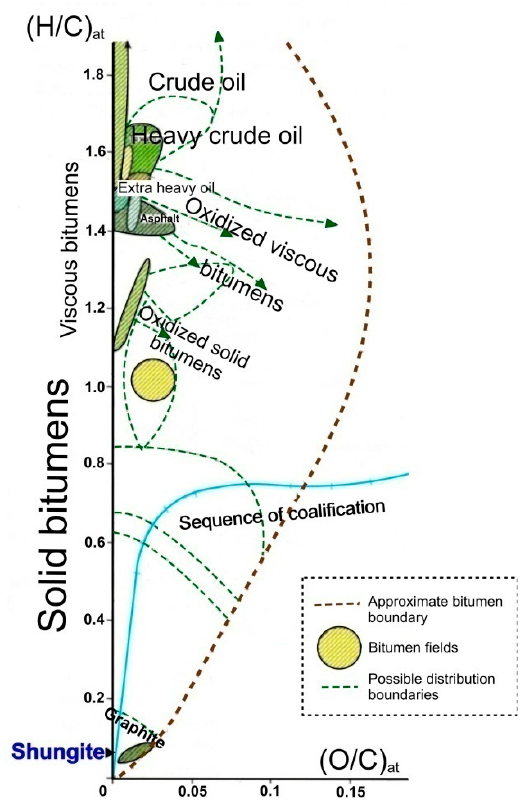
Figure 1. Van Crevelen diagram of carbonization (dehydrogenation) showing the alteration of H/C atomic ratios versus O/C. D sp 2 C (represented by shungite) is limited to a narrow region close to the end member of pure carbon (adapted from [2]).